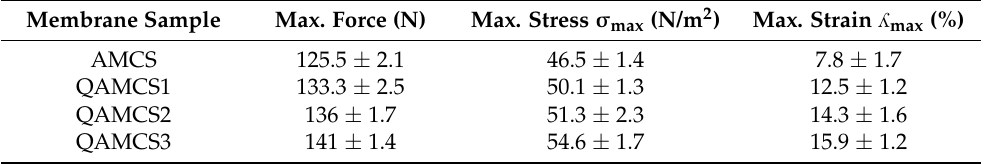
Table 2. Mechanical parameters of aminochitosan, quaternized aminochitosan 1, quaternized aminochitosan 2 and quaternized aminochitosan 3 membranes. Values are expressed as means and standard deviations ( ± SD; n = 3).